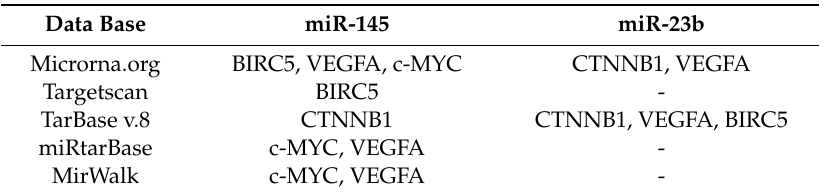
Table 1. In-silico analysis of di ff erent online databases identified potential microRNA (miR)-145 and miR-23b pairing sequences in mRNAs of the following oncoproteins: vascular endothelial growth factor (VEGF) (VEGFA, the most common isoform overexpressed in cancer cells), c-MYC, survivin (BIRC5) and β -catenin